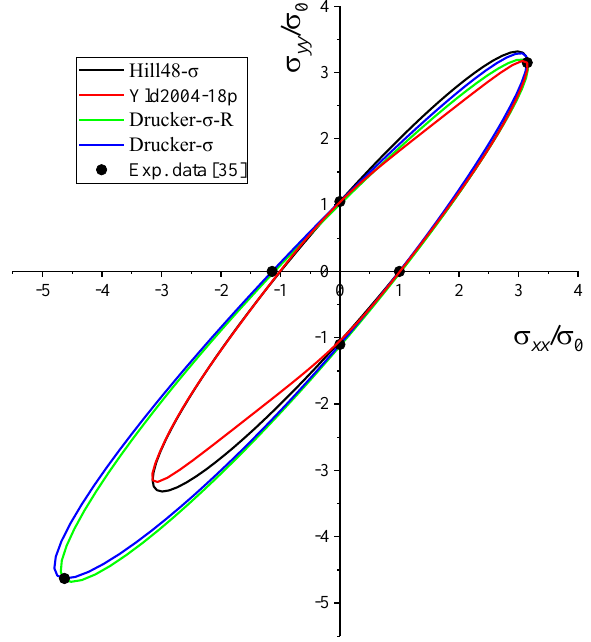
Figure 12. Predicted yield locus of various criteria with experimental data in-plane stress.